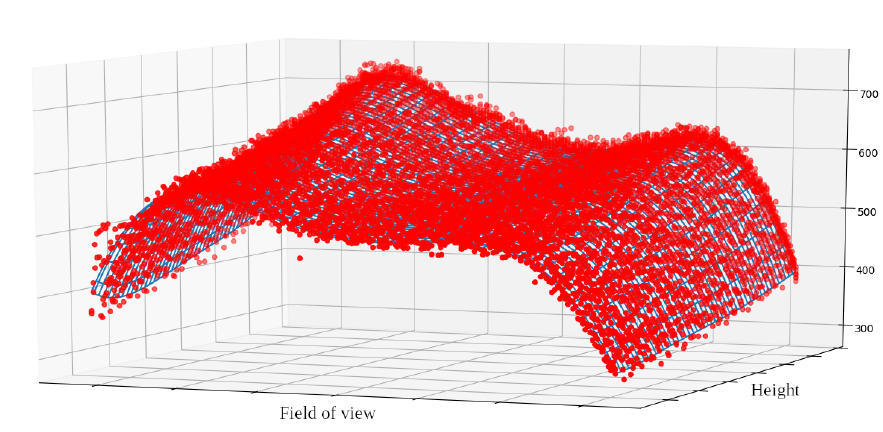
Figure 5. Gaussian process reconstruction of digital counts over a tilted reference plate as a function of camera viewing angle ( − 26 ◦ to 26 ◦ ) and height above plate (45.4–58 cm) for a single wavelength. The red points are samples, and the blue grid mesh underneath is the reconstruction. A slight difference in the strength of the two lamps is